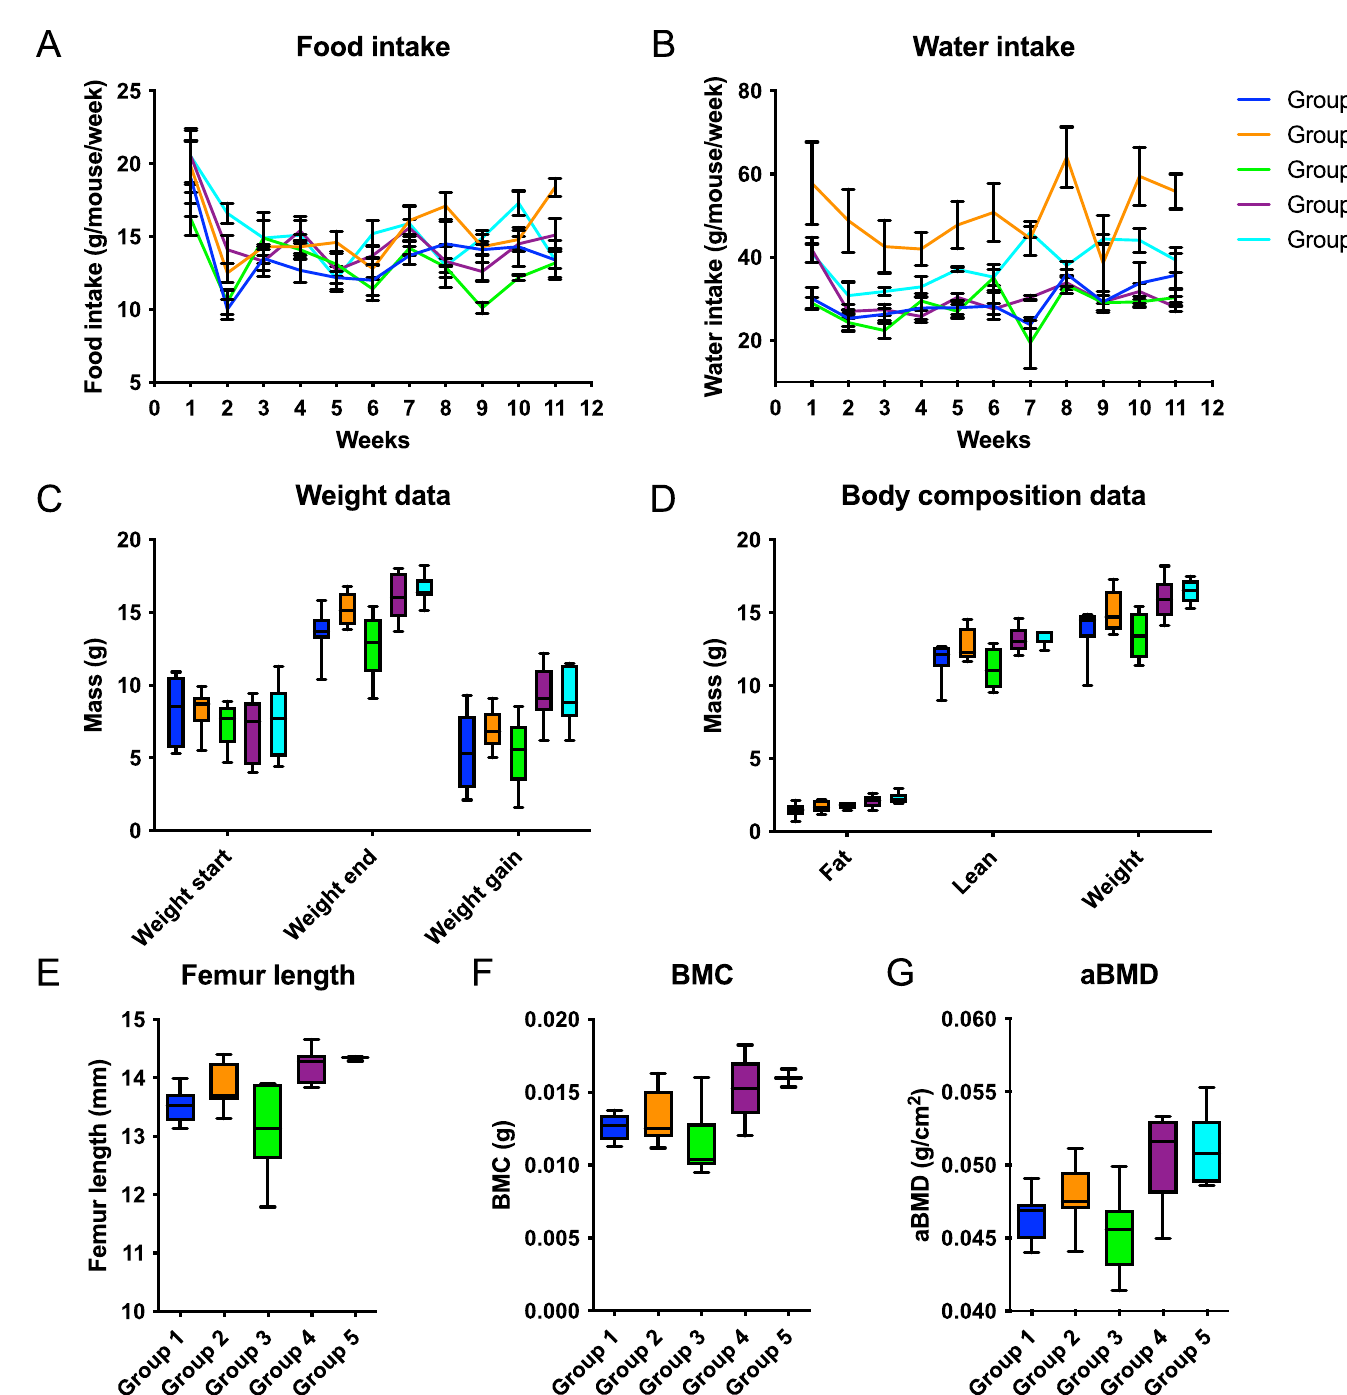
Fig 2. A: Average intake (g) of food pr. mouse/gr./w (w 1–11), Mean ± SD. G1 (13.6 +/- 3.1), G2 (15.4 +/- 2.5), G3 (13 (+/- 2.5), G2 > G3 (p = 0.01), G4 (14.6 +/- 2.9), and G5 (15.4 +/- 2.8), G5 > G3 (p = 0.01)). B: Average intake (g) of water pr. mouse/gr./w (w 1–11), Mean ± SD. G1 (29.5 (+/- 8.3); G2 (50.2 (+/- 20.3), G2 > G1 (p < 0.001); G3 28.1 (+/- 6.9), G2 > G3 (p < 0.001); G4 (30.3 (+/- 4.2), G5 (38.2 (+/- 5.7), G5 > G3, G5 > G4 (p � 0.001). C: Body Weight data (BW) (g) (weight start, weight end and weight gain) pr. mouse/gr./w (w1-12), Mean ± SD. Weight start: G1 (8.3 +/- 2.4), G2 (8.3 +/- 1.3), G3 (7.2 +/- 1.4), G4 (6.7 +/- 2.1) and G5 (7.4 +/- 2.5); Weight end: G1 (13.6 +/- 1.5), G2 (15.2 +/- 1.1), G3 (12.7 +/- 2.1), G4 (16.1 +/- 1.6) and G5 (16.6 +/- 0.9); Weight gain: G1 (5.4 +/- 2.5), G2 (6.9 +/- 1.3), G3 (5.4 +/- 2.3), G4 (9.3 +/- 1.9) and G5 (9.2 +/- 1.9). G2 > G1 (p < 0.05), G2 > G3 (N) (p < 0.01), G4 and G5 both > G3 (p � 0.001). D: Body composition data, Body scan (g) (fat, lean body weight (LBW), weight total (WT)) pr. mouse/gr./w (w1-12) Mean ± SD. Fat: G1 (1.5 +/- 0.4), G2 (1.8 +/- 0.3), G3 (1.5 +/- 0.4), G4 (2.1 +/- 0.5), G5 (2.2 +/- 0.4), G4 > G3 (p = 0.02), G5 > G3 (p < 0.01)); LBW: G1 (12 +/- 1.3), G2 (13 +/- 1), G3 (10.8 +/- 1.5), G4 (13.5 +/- 0.9), G5 (13.7 +/- 0.7), G2 > G3 (p < 0,01), G4 > G3 (p < 0.001),